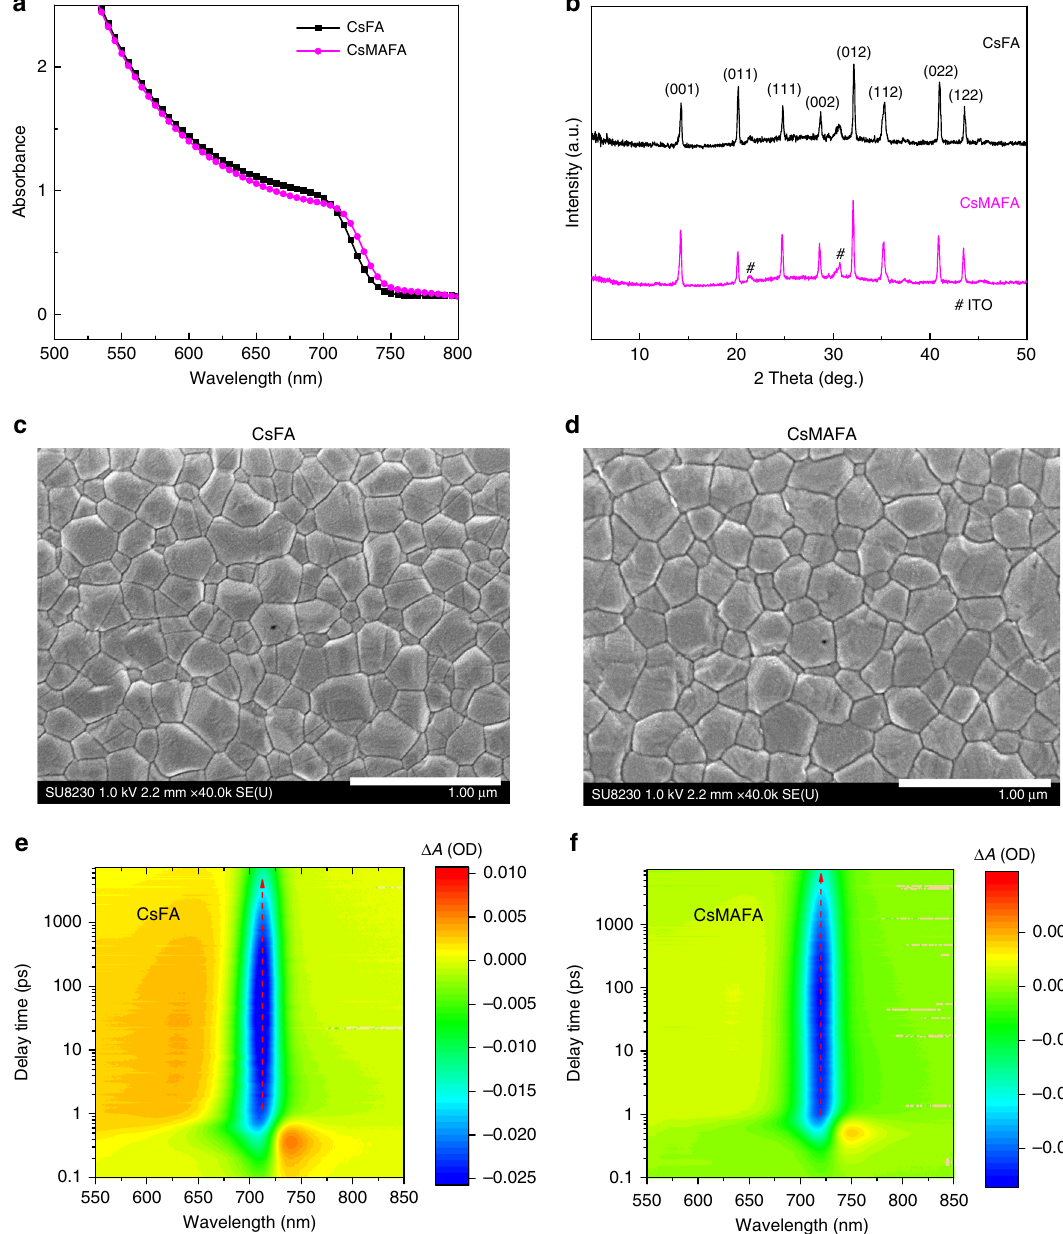
Fig. 1 Optical and structural characterization of wide-bandgap perovskite fi lms. a Absorbance of perovskite fi lms, corresponding to absorption onset of 1.67 eV for CsFA and 1.65 eV for CsMAFA. b XRD patterns of CsFA and CsMAFA perovskite fi lms on ITO/TiO 2 – Cl substrates. c – d SEM images of CsFA and CsMAFA perovskite fi lms on ITO/TiO 2 – Cl substrates. The scale bars are 1 μ m. e – f Transient absorption studies of CsFA and CsMAFA fi lms on glass substrates. The vertical red dashed lines indicate the peak position of photobleaching band over a probe delay time of 1 – 7000ps. OD optical high-ef fi ciency c-Si solar cells 37 needed in the future realization of The photovoltaic performances of the best-performing CsFA and CsMAFA perovskite solar cells are shown in Fig. 2b and monolithic tandem devices. To explore fi lm uniformity, we Table 1. The CsMAFA devices exhibit a best stabilized PCE of fabricated large-area CsMAFA PSCs with an active area over 1 cm 2 (Fig. 2d). The devices exhibit a maximum PCE of 19.3% with 20.7% (Supplementary Fig. 6) and negligible hysteresis, whereas a low V oc de fi cit ( E g − V oc ) of 410 mV. We tracked the operating the CsFA devices have considerable hysteresis, in agreement with stability of CsFA and CsMAFA perovskite solar cells at their previous studies 12,14,17 . The integrated J sc values from EQE spectra (Fig. 2c) are consistent with the J − V measurements maximum power point (MPP) conditions under one sun (within 5% deviations). The high FF values that exceed 80% and illumination (Supplementary Fig. 7). The CsMAFA solar cells low V oc de fi cit in CsMAFA devices are comparable to those of the have stable V oc under illumination, and they also exhibit best-reported lower-bandgap (below 1.6 eV) PSCs 18 – 20 . The comparable operating stability to the case of CsFA and maintain more than 97% of their initial ef fi ciencies following continuous CsMAFA wide-bandgap PSCs achieved here exhibit a low V oc MPP operation for 11 h. de fi cit, suf fi ciently large J sc , and high FF and thus match well with